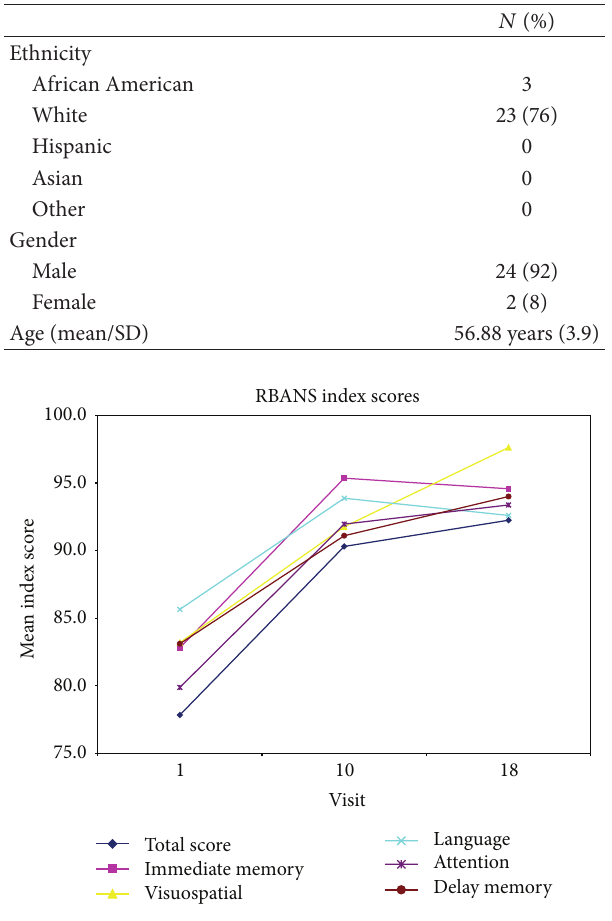
Figure 1: This figure illustrates changes in Repeatable Battery for the Assessment of Neuropsychological Status index scores over time.